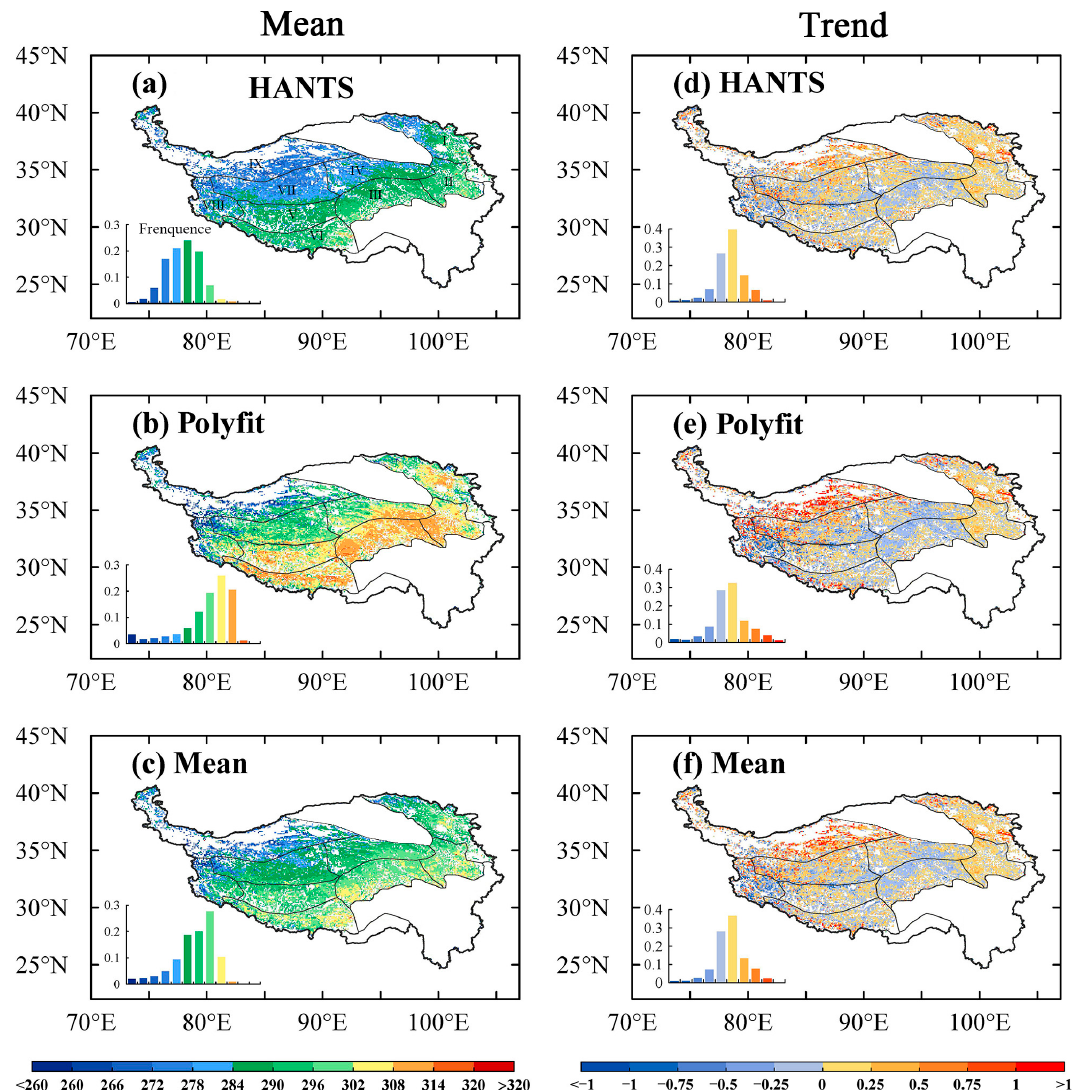
Figure 2. Distributions of the end of season (EOS) (calendar day) and their change trends (days/year). Multi-year means of the EOS obtained using the ( a ) HANTS method and ( b ) Polyfit method. ( c ) Average values of the HANTS and Polyfit methods. Trends of the EOS obtained using the ( d ) HANTS methods and ( e ) Polyfit method. ( f ) Average values of the EOS trends obtained using the HANTS and Polyfit methods.